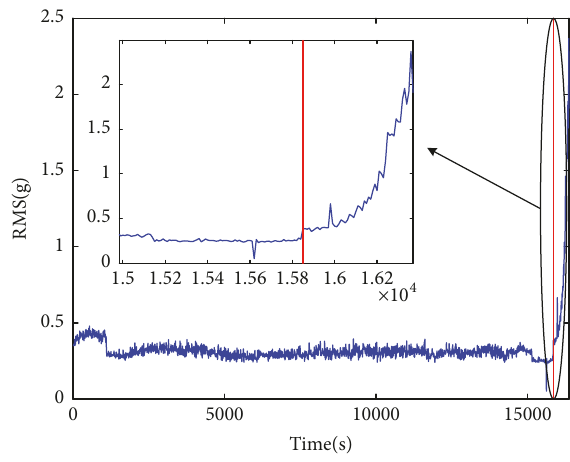
Figure 7: Typical bearing vibration signals. Figure 8: RMS results of the